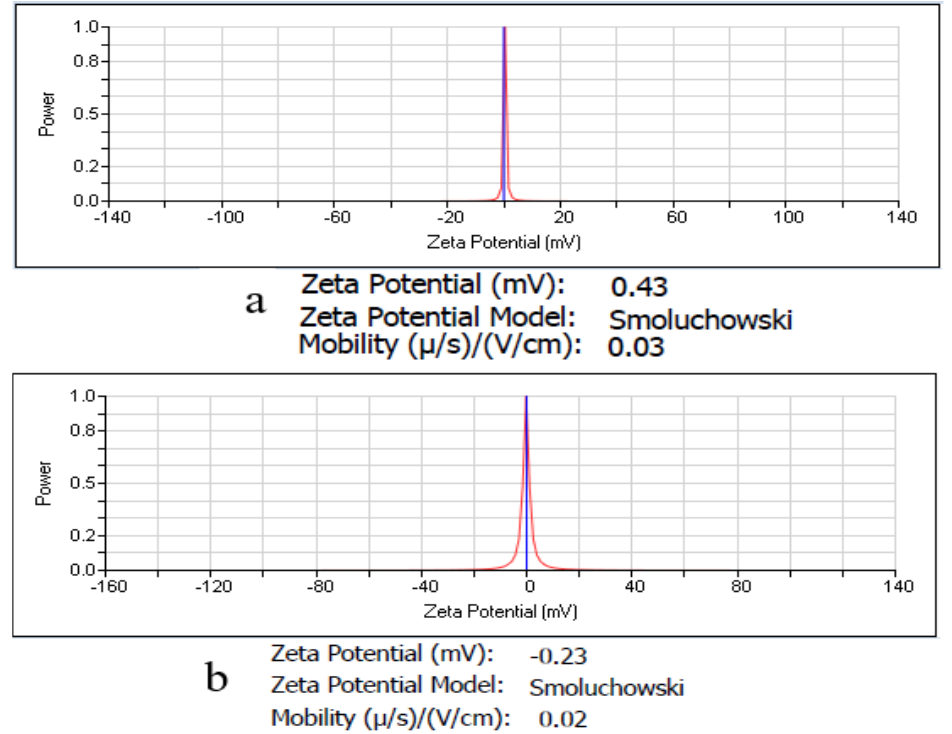
Fig. 5. Zeta potential of (A) raw MWCNT and (B) chitosan-modified MWCNT nanocomposites